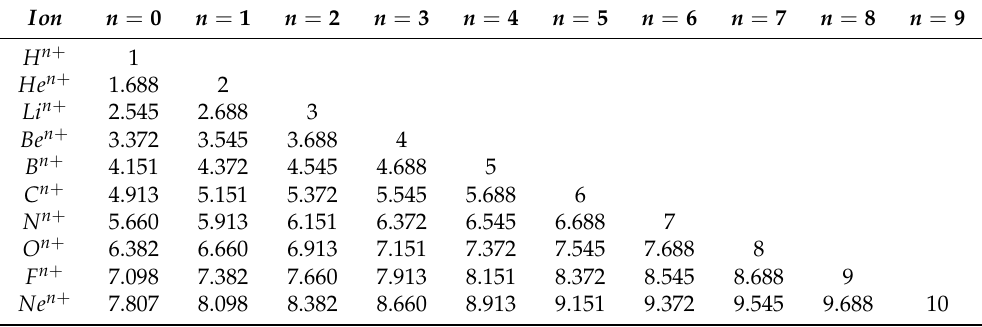
Table 2. Variational parameter α (in atomic